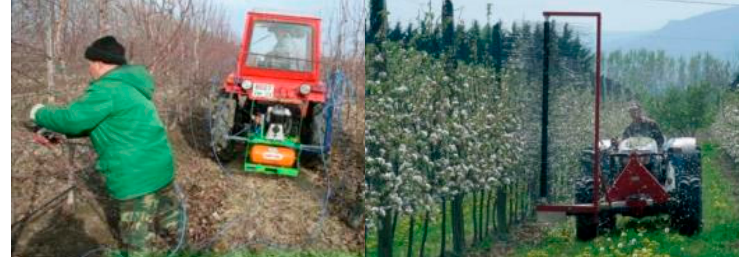
Figure 4. Pruning activity: assisted manual pruning ( left ) and mechanical pre-pruning ( right ) [25].